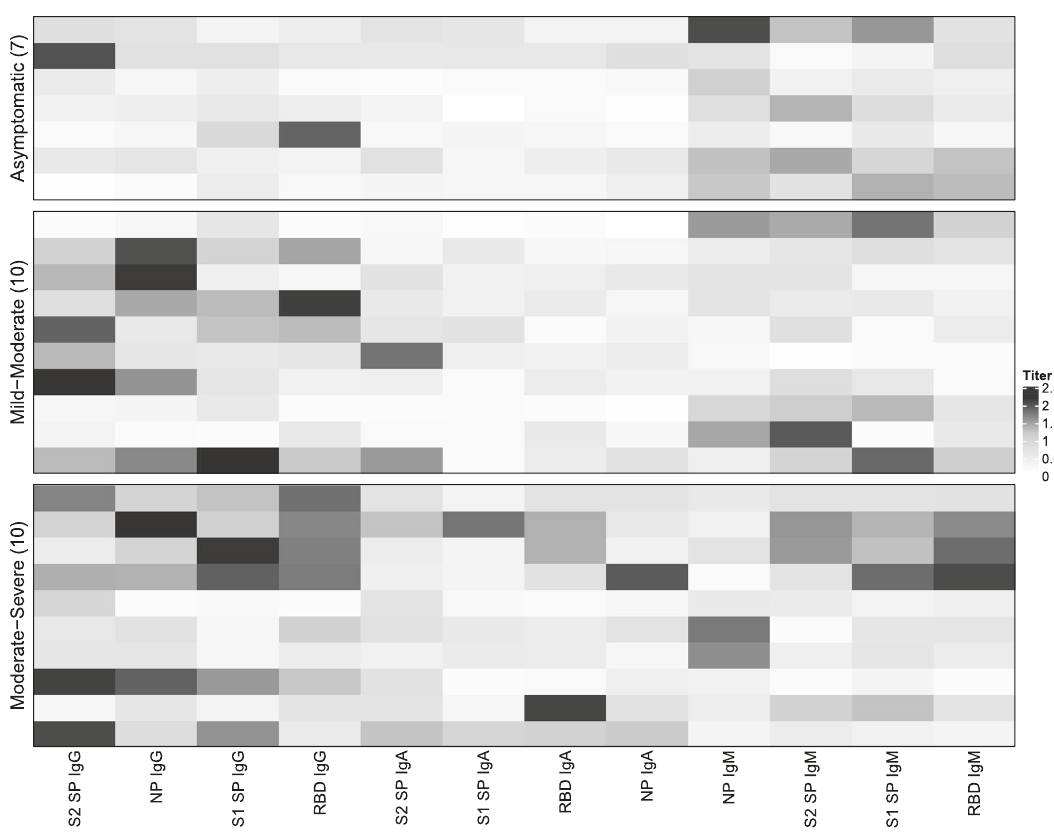
Fig. 3 Heatmap of IgG, IgA, and IgM titers against SARS-CoV-2 antigens in asymptomatic and symptomatic COVID-19-positive participants. Heatmap generated via an agglomerative hierarchical approach showing differences in IgG, IgA, and IgM titers against spike 1 glycoprotein (S1 SP), spike 2 glycoprotein (S2 SP), receptor-binding domain (RBD), and nucleoprotein (NP) in COVID-19-positive asymptomatic participants ( n = 7), participants who experienced mild-moderate symptoms ( n = 10), and participants who experienced moderate-severe symptoms ( n = 10). Each row represents titers in an individual participant. The color key indicates titer, with darker shades indicating elevated titers and lighter shades indicating lower